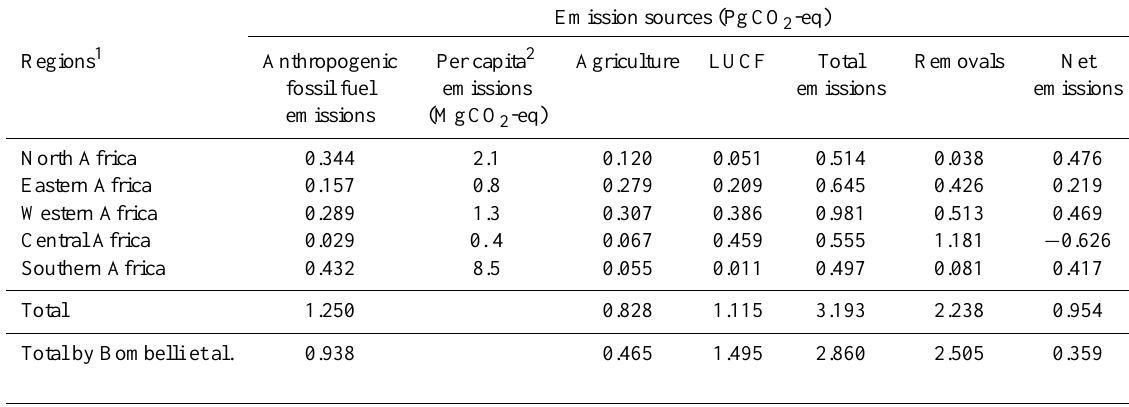
Table 1. GHGs emission sources for five different African Regions.